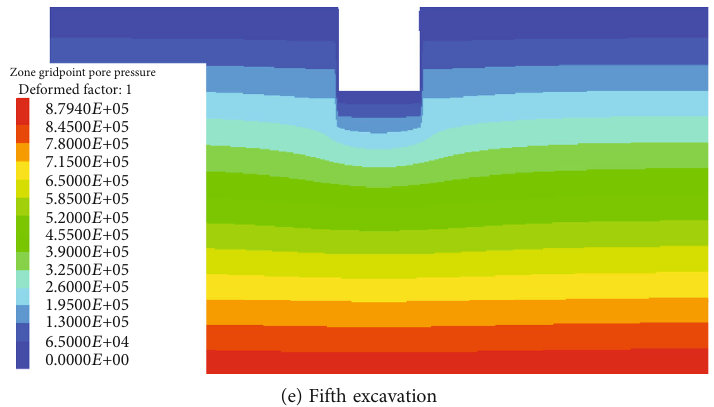
Figure 8: Pore water pressure cloud diagram of each excavation step.